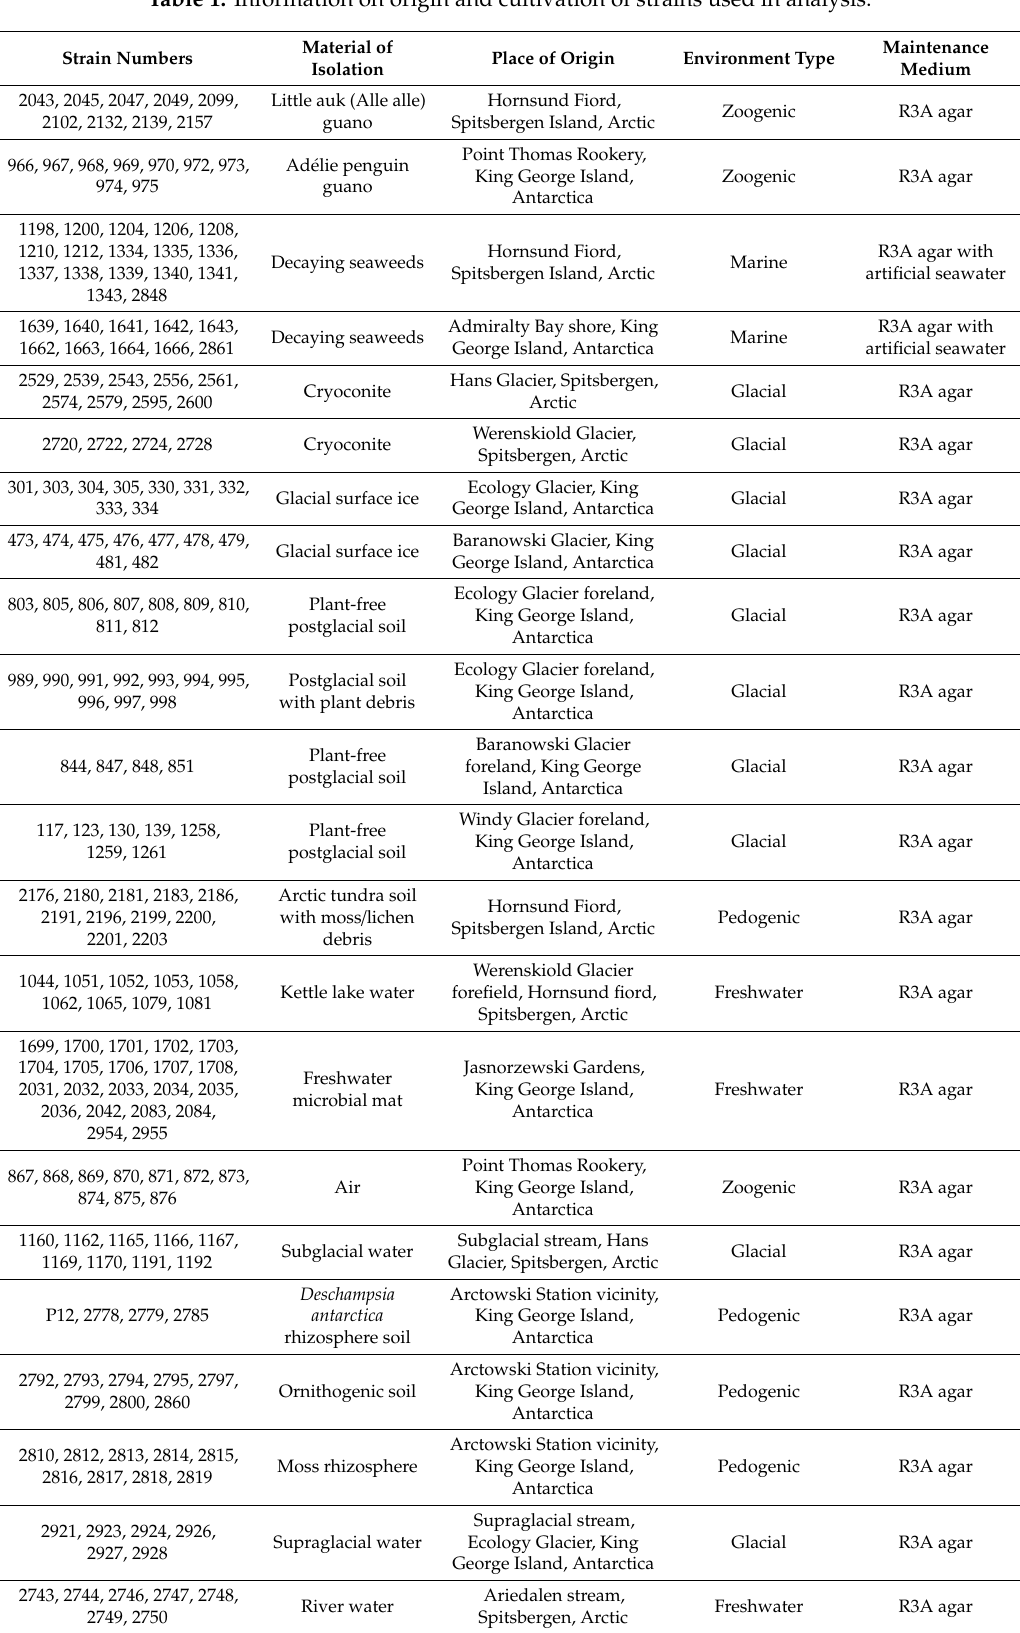
Table 1. Information on origin and cultivation of strains used in